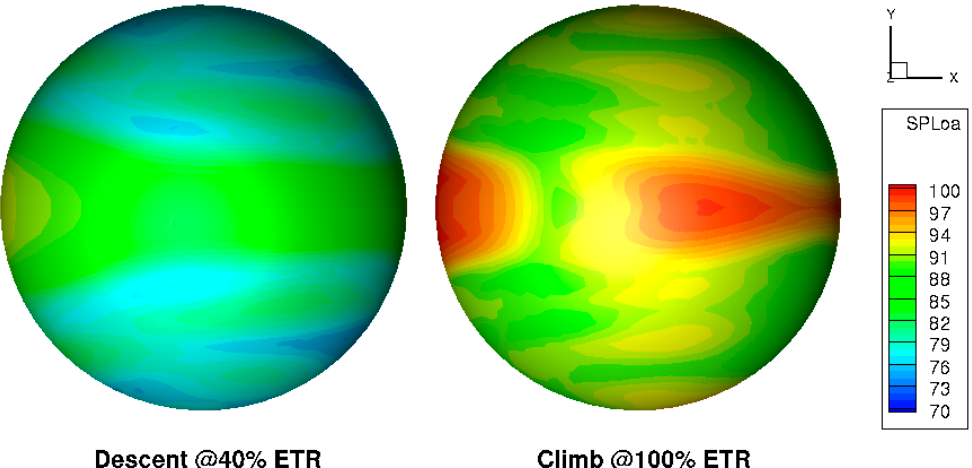
Figure 21. Motorization 2, OASPL, in decibels, on the sphere, top view, in the two flight conditions analysed.